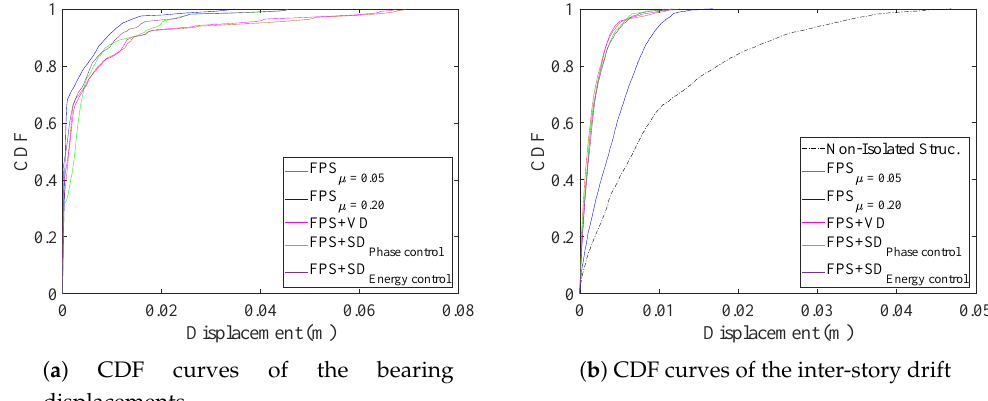
Figure 16. CDF curves under the Northridge earthquake.